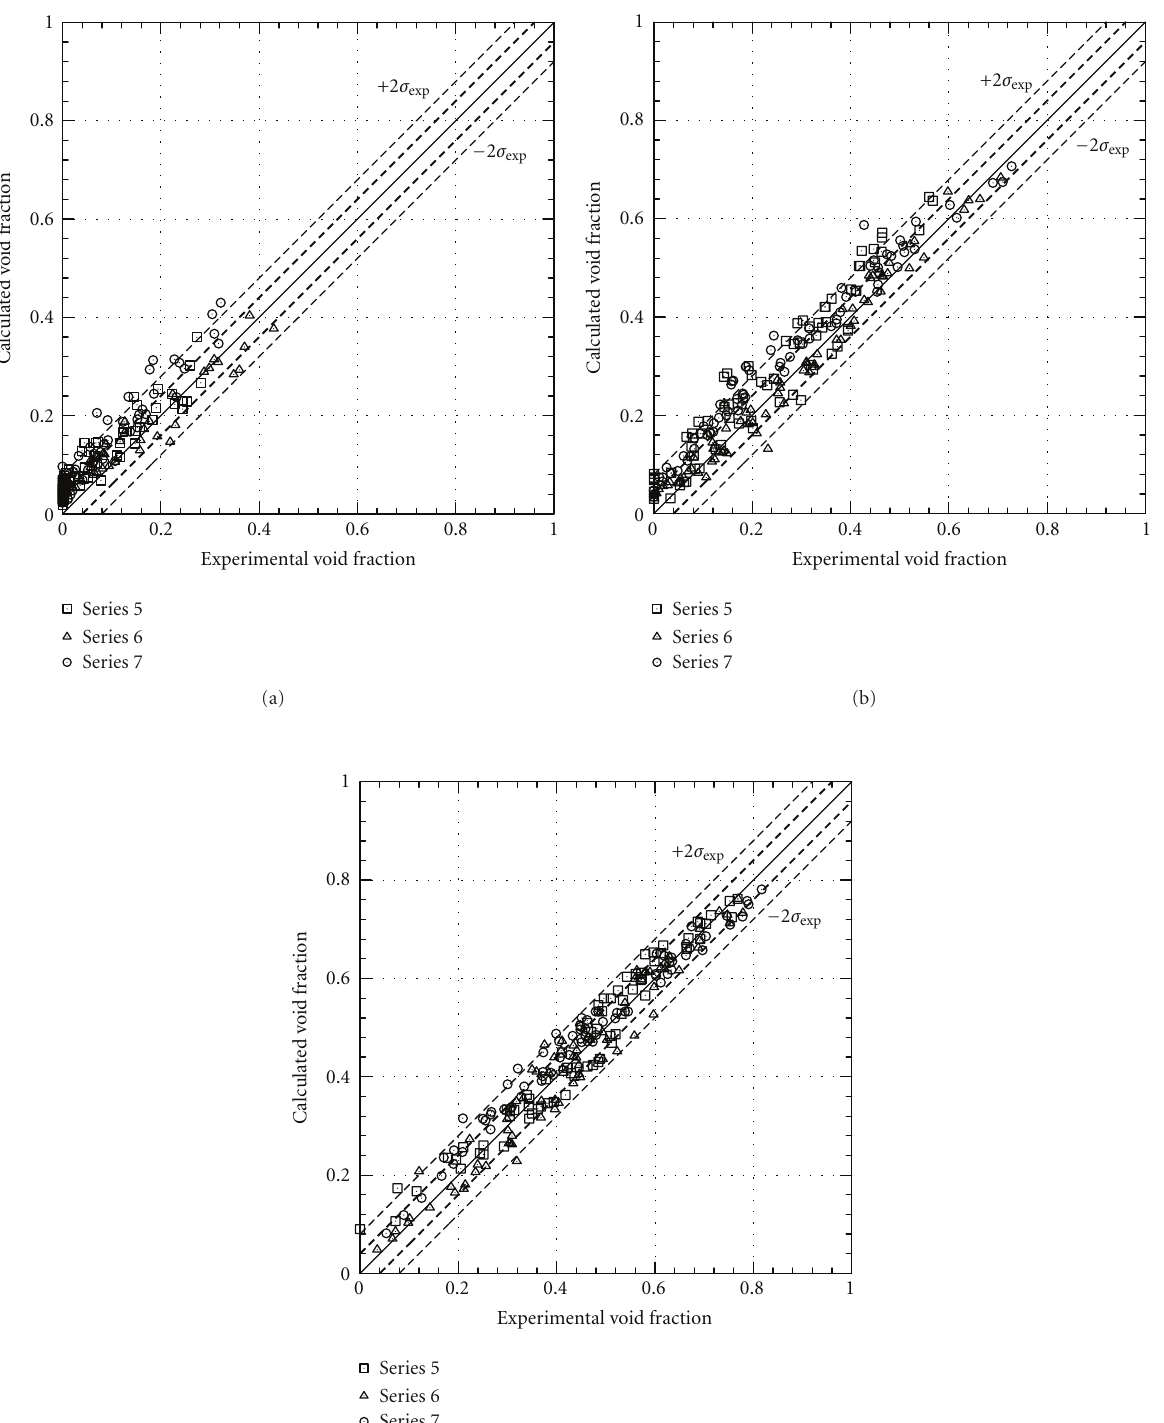
Figure 4: Steady-state rod bundle exercises. Comparison of calculated void fraction profiles in the central subchannel against experimental data: lower (a), medium (b), and upper (c)